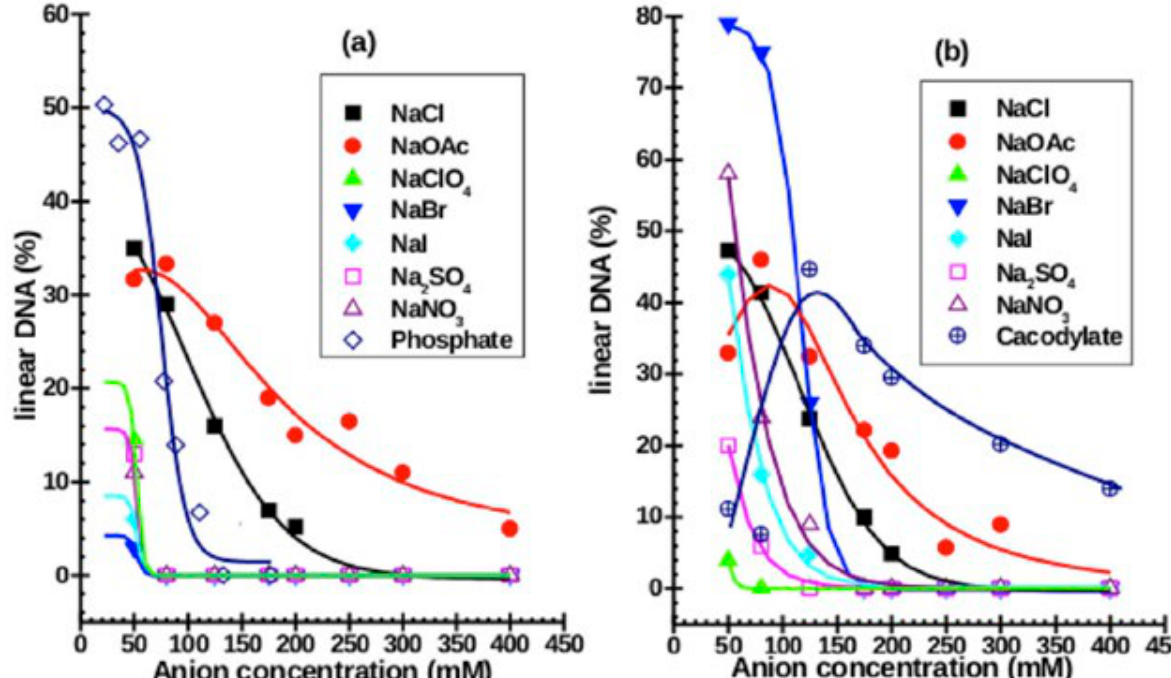
Figure 3. Enzyme cutting efficiency versus the concentration of the electrolyte at pH 7.5, for a set of different 1:1 sodium salts. The buffer used was phosphate (a) or cacodylate (b). Reprinted from Ref. 44, Copyright 2016, with permission from